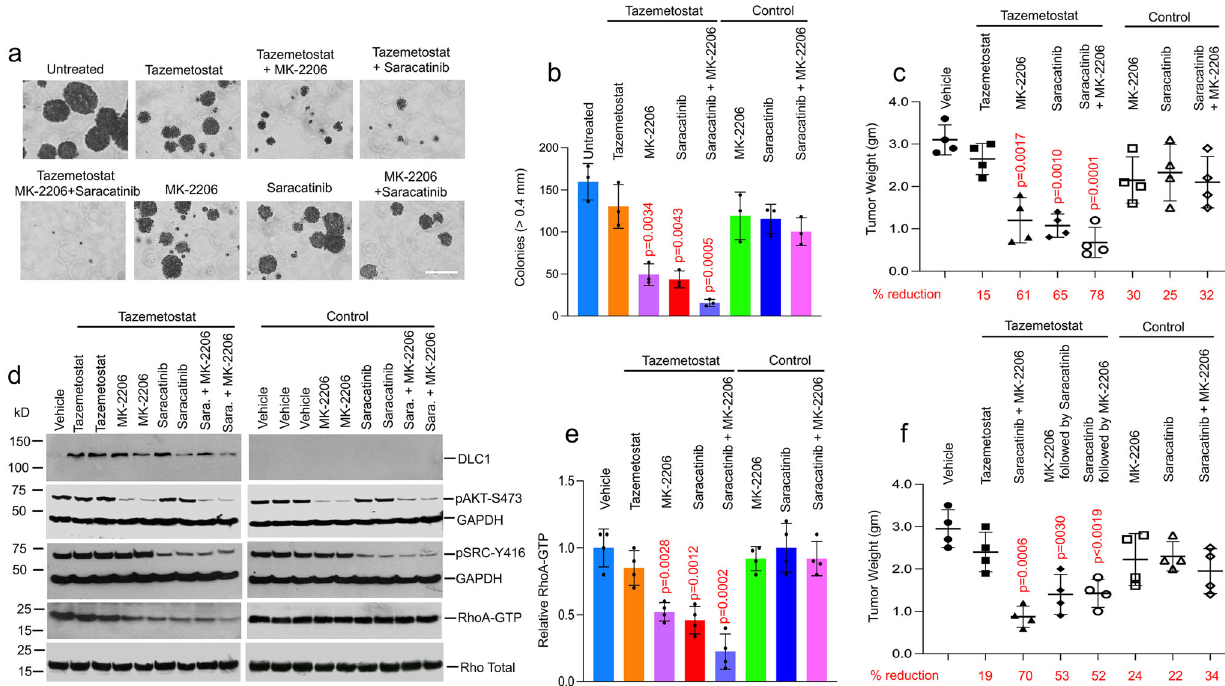
Fig. 3 Saracatinib and MK-2206 cooperate with Tazemetostat in reducing anchorage-independent and tumor xenograft growth. a , b Anchorage- independent growth of A549 cells after 3 weeks treatment with Tazemetostat and MK-2206 and/or Saracatinib. a In the presence of Tazemetostat, MK-2206 and/or Saracatinib treatment inhibited growth and colony formation in soft agar. Bar, 2 mm. b Quanti fi cation of agar colonies in a (>0.4 mm). For each group, mean and SD are shown. N = 3 independent experiments. Error bars represent SD. c – e Response of mouse A549 xenograft tumors to treatment with Tazemetostat (3 weeks) and MK-2206 and/or Saracatinib (2 weeks). For the statistical analysis, a parametric unpaired t -test with Welch ’ s correction was performed for b , c , e , and f using Prism software. The statistical test was two-sided, and no adjustments were made for multiple comparisons. p = 0.0034 for untreated versus Tazemetostat + MK-2206, p = 0.0043 for untreated versus Tazemetostat + Saracatinib, and p = 0.0005 for untreated versus Tazemetostat + MK-2206 + Saracatinib treatment, respectively. c For each treatment group, individual tumor weights, mean, and SD are shown. Error bars represent SD. The numbers below the graph represent the percent reduction in tumor weight for each treatment group compared with the untreated vehicle control. N = 4 mice per group. p = 0.0017 for vehicle versus Tazemetostat + MK-2206, p = 0.0010 for vehicle versus Tazemetostat + Saracatinib, and p = 0.0001 for vehicle versus Tazemetostat + MK-2206 + Saracatinib treatment, respectively. d MK-2206 or Saracatinib treatment of tumors ef fi ciently inhibited AKT and SRC activities but only reduced RhoA-GTP in DLC1-positive tumors (Tazemetostat treatment group, fi rst panel), and not in DLC1-negative tumors (control, second panel). Treatment with all three drugs reduced RhoA-GTP to a greater degree than two drugs. e Graph shows mean RhoA-GTP ± SD within each group. Error bars represent SD. N = 4 mice tumors. p = 0.0028 for vehicle versus Tazemetostat + MK- 2206, p = 0.0012 for vehicle versus Tazemetostat + Saracatinib, and p = 0.0002 for vehicle versus Tazemetostat + MK-2206 + Saracatinib treatment, respectively. f Tumor xenograft treatment with two inhibitors per week. Mice with tumors were treated with Tazemetostat for a total of 3 weeks. In the fi rst week, they were treated only with Tazemetostat, and in the second week, they were treated with either MK-2206 or Saracatinib with Tazemetostat. In the third week, they continued to be treated with Tazemetostat but were switched to Saracatinib if they had received MK-2206 in the second week or to MK- 2206 if they had received Saracatinib in the second week. For each treatment group, individual tumor weights, mean, and SD are shown. Error bars represent SD. The positive control was treated with all three inhibitors during the second and third weeks. The numbers below the graph represent the percent reduction in tumor weight for each treatment group compared with the untreated vehicle control. N = 4 mice per group. p = 0.0006 for vehicle versus Tazemetostat + MK-2206 + Saracatinib, p = 0.0030 for vehicle versus Tazemetostat + Saracatinib treatment for second week, and p = 0.0019 for vehicle versus Tazemetostat + MK-2206 treatment for second week, respectively. Source data are provided as a Source Data fi